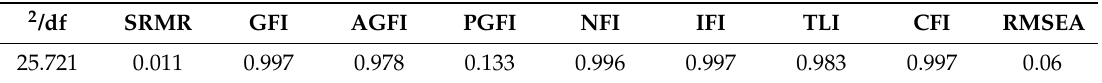
Table 5. Fit indices for the structural models.